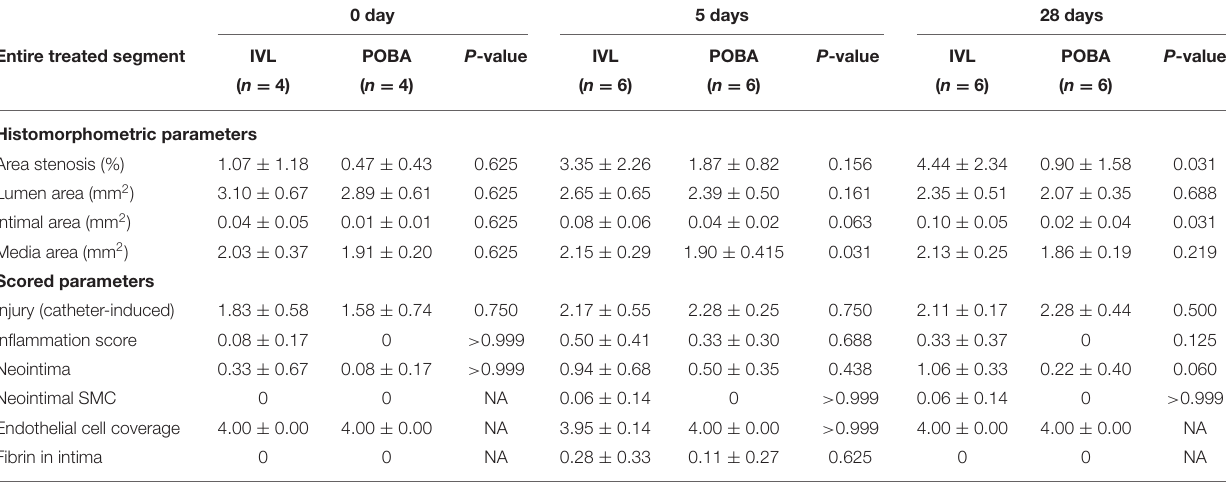
TABLE 2 | Histomorphometric and qualitative histological analyses of entire treated segments. 0 day 5 days 28 days Entire treated segment